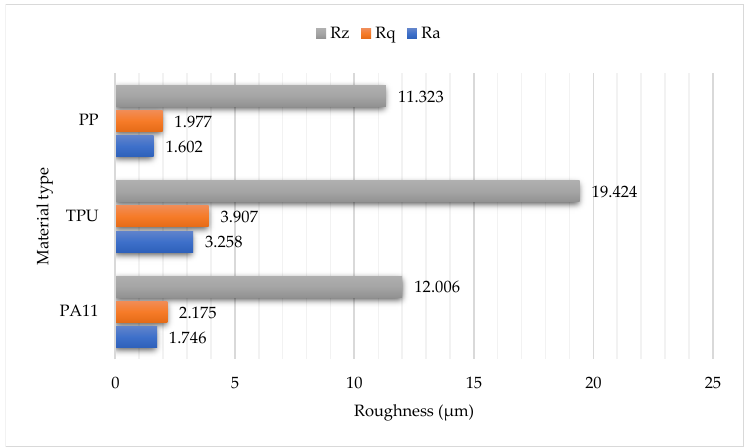
Figure 10. The standard deviation of the roughness for the samples grouped by material.